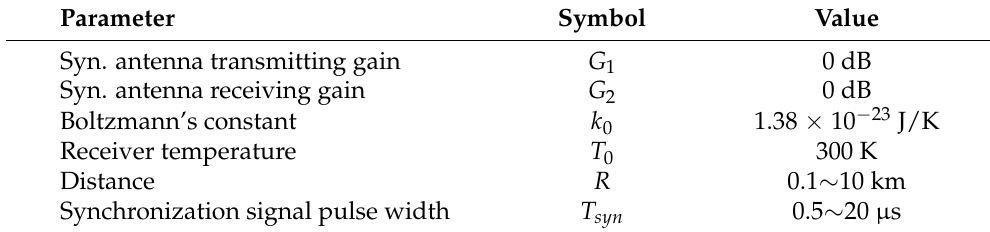
Table 1. The parameters used for synchronization simulation